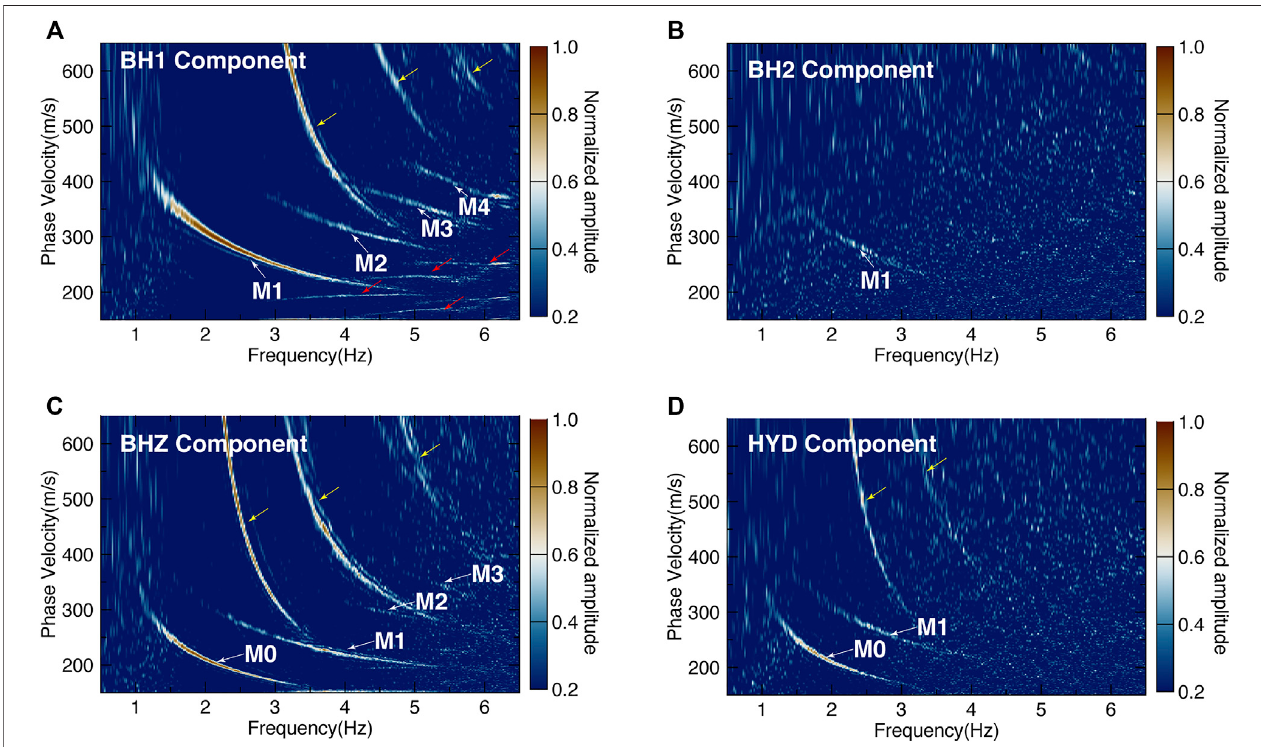
FIGURE3| Four-component(4C)velocityspectra(VSs)calculatedfromthepositivebranchofthe4CCRGsofOBSstationC22.TheM0 – M4denotethedispersive Scholte-wave mode numbers. The yellow and red arrows denote two different patterns of dispersive spectral-spatial aliasing.